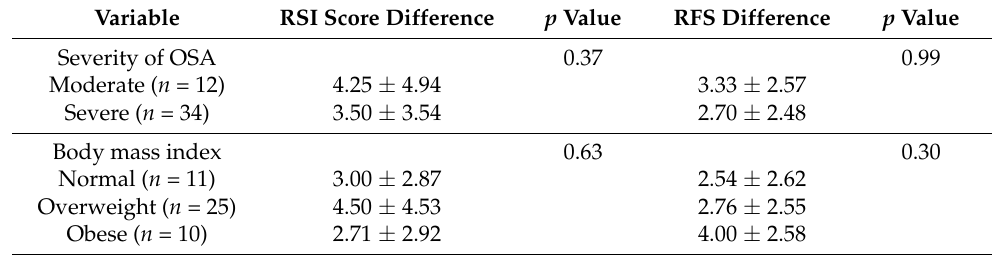
Table 6. Changes in reflux symptom index scores and reflux finding